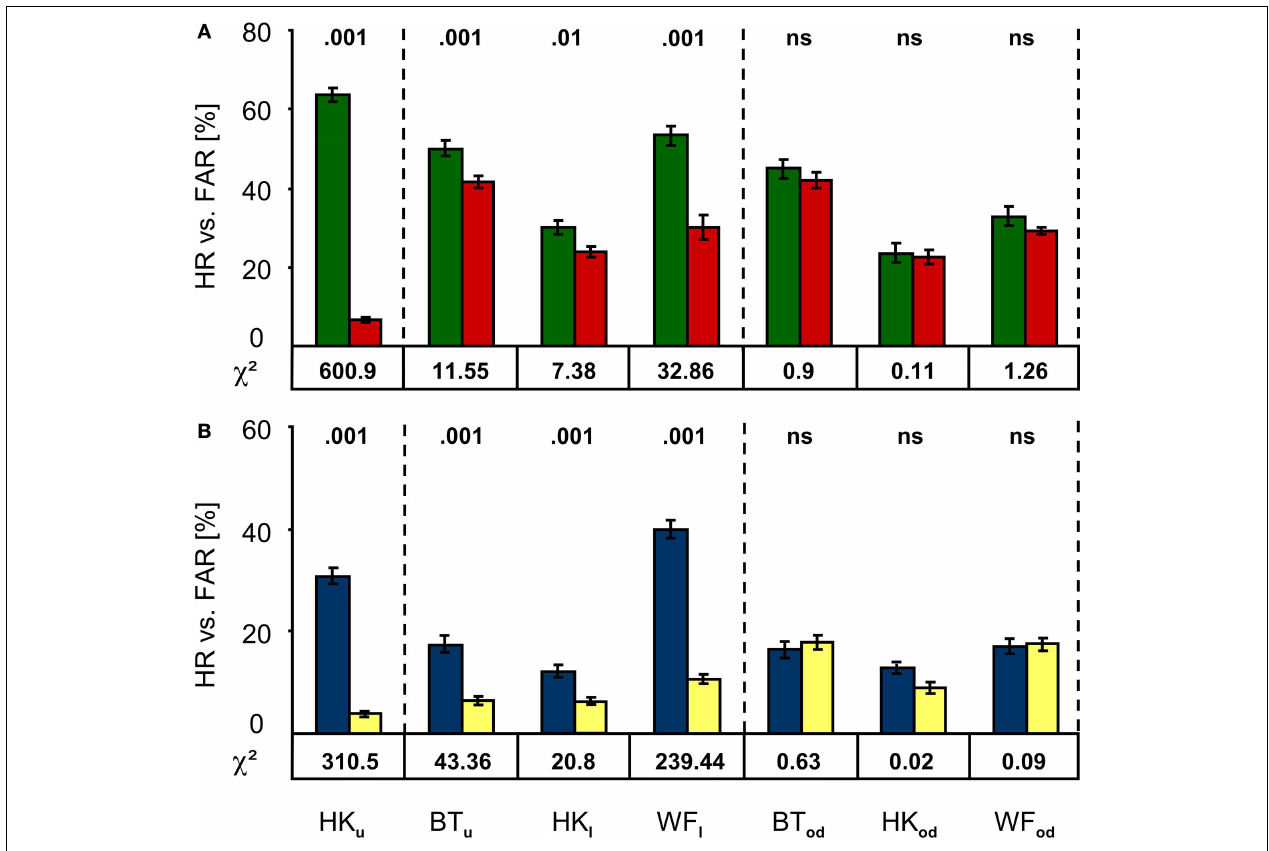
(B) Results for the un-cued condition follow the same pattern; again, the Hit Rate (blue) exceeds the False Alarm Rate (yellow) signifi cantly at all positions except those falling onto the optic disc. Subscript indices indicate the target positions (u, upper; l, lower; od, optic disc). Chi-square values are given below, the corresponding P - values above the bars; error bars indicate ± 1 standard error of the